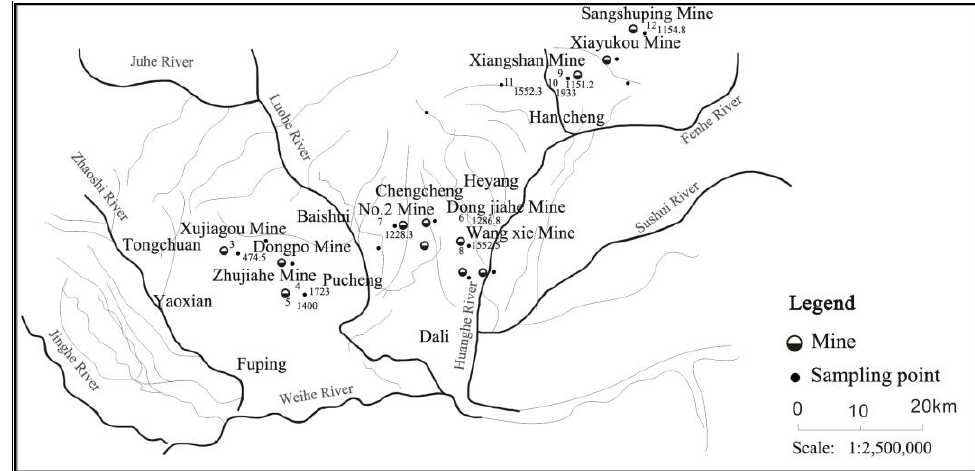
Figure 2. Field Sampling.